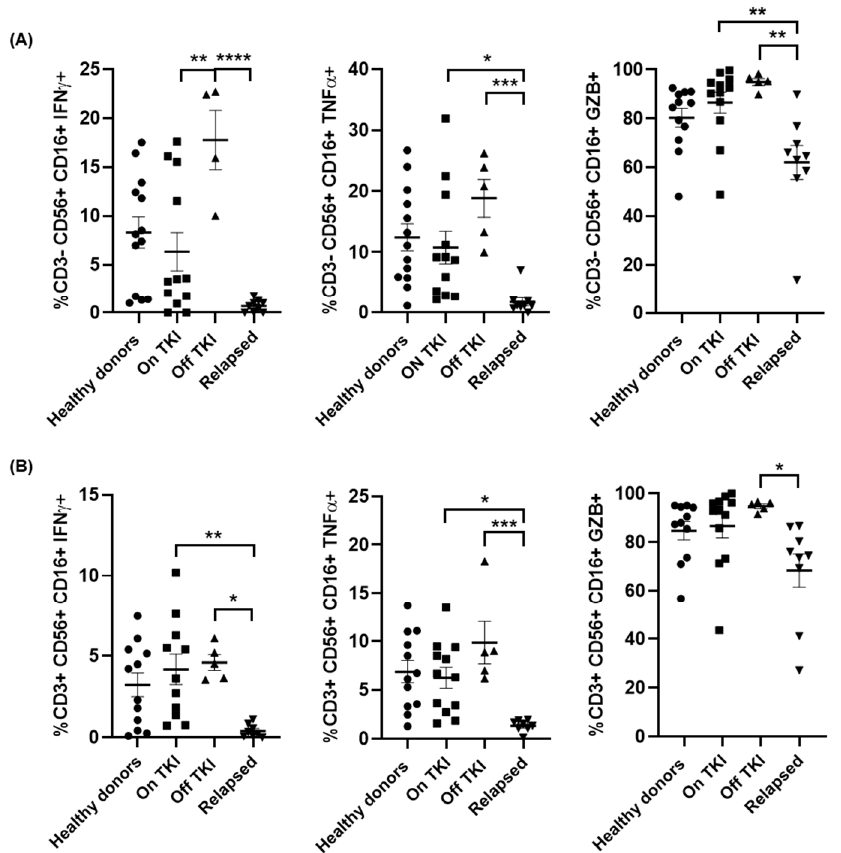
Figure 2. Synthesis of cytokines from NK and NKT cells from PBMCs of different groups of pa- tients with CML. Analysis by flow cytometry of the intracellular expression of interferon gamma (IFN γ ), tumor necrosis factor alfa (TNF α ) and granzyme B (GZB) in CD3- CD56+ CD16+ NK cells ( A ) and CD3+ CD56+ CD16+ NKT cells ( B ) from each group of patients and healthy donors (Healthy donors ( ● ), patients On TKI ( ■ ), patients Off TKI who did not relapse ( ▲ ), and patients Off TKI who relapsed ( ▼ )). Each dot corresponds to one sample and lines represent mean ± SEM. Statistical significance was calculated using one-way ANOVA and Tukey’s multiple comparisons test. * p < 0.05; ** p < 0.01; *** p < 0.001; **** p < 0.0001.